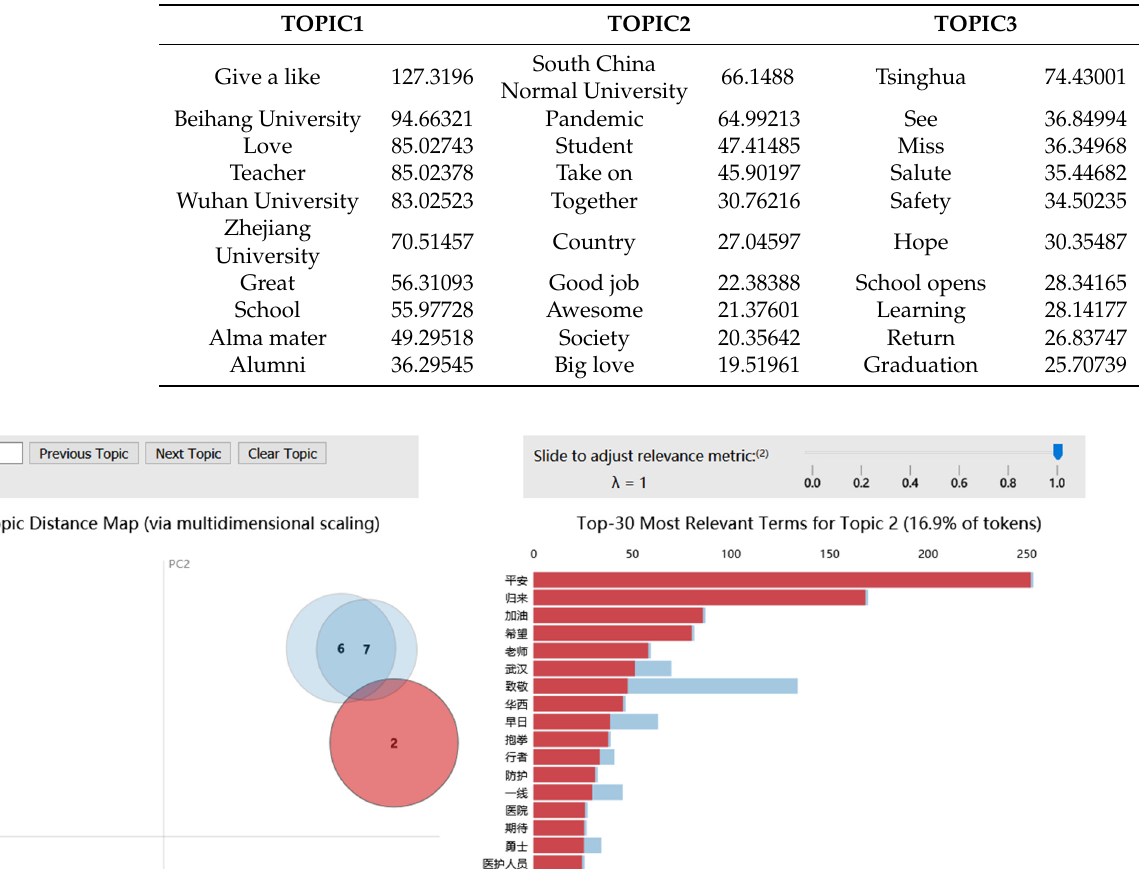
Table 3. Partial running results of LDA topic model.